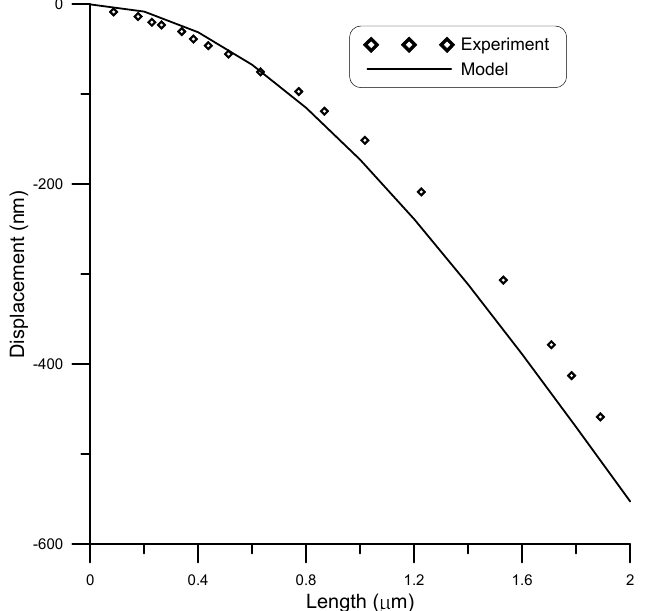
Figure 14. Displacement of a 2 µ m long beam of rectangular cross-section of 150 nm width and 50 nm thickness under a load of 1.4 nN, compared to experimental data [27].